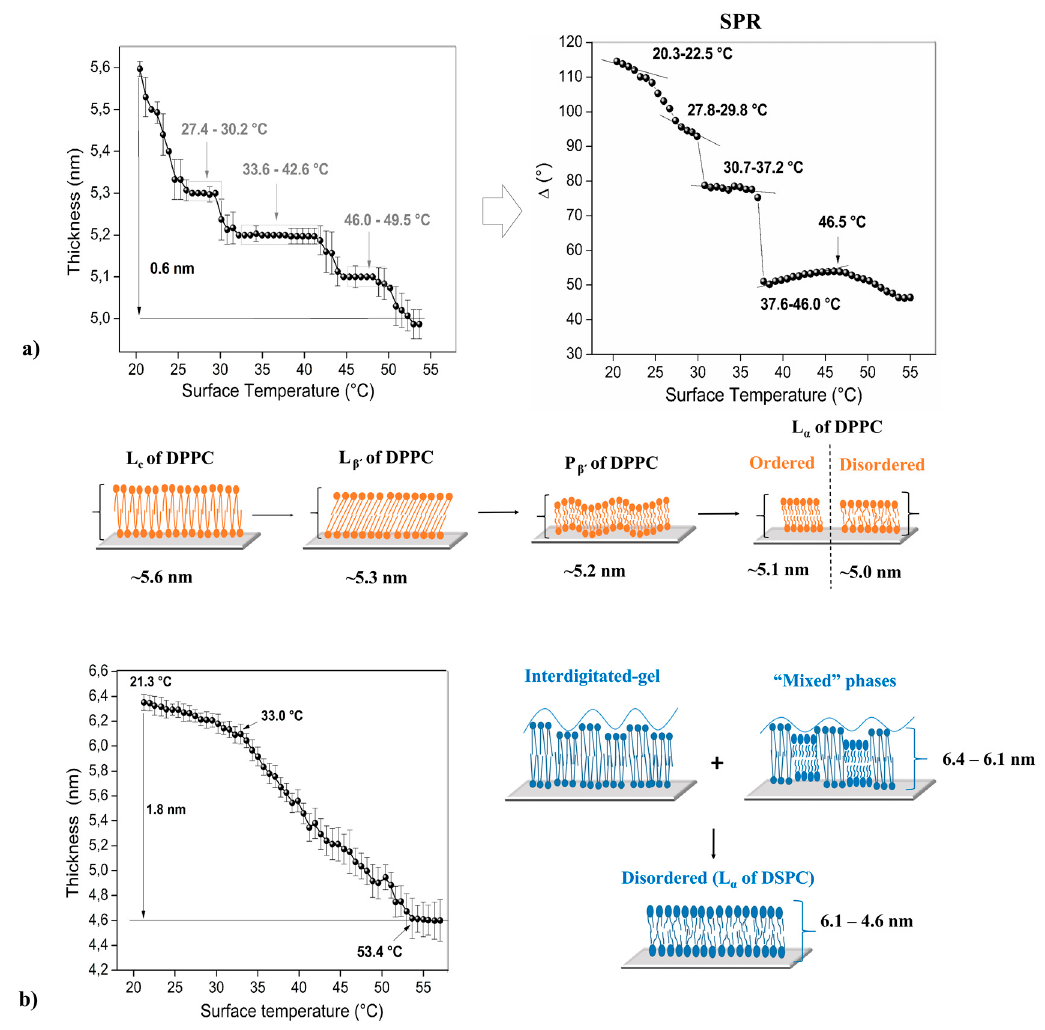
cycles for ( a ) 1,2-dipalmitoyl- sn -glycero-3-phosphocholine (DPPC) (ellipsometry and SPR) and Figure 2. Optical response and some schemes of the bilayers measured under heating cycles for ( a ) ( b ) 1,2-distearoyl- sn -glycero-3-phosphocholine (DSPC) 1,2-dipalmitoyl-sn-glycero-3-phosphocholine (DPPC ) (ellipsometry and SPR) and ( b ) 1,2-distearoyl- sn-glycero-3-phosphocholine (DSPC) (ellipsometry).